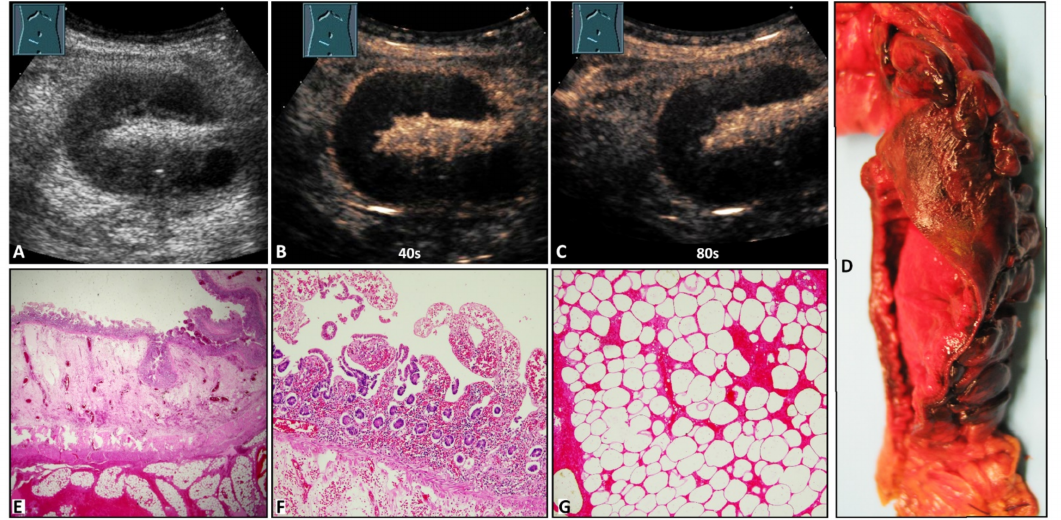
Figure 2. A 42-year-old male patient with acute peritoneal pain in the right lower abdomen and a pal- pable subcutaneously located tumor in the form of a Spieghel’s hernia. ( A ) B-mode ultrasound shows a standing loop of small bowel. ( B , C ) Contrast-enhanced ultrasound shows absent enhancement of the bowel wall after 40 s and 80 s. ( D ) Macroscopic evaluation shows a color change to deep red in the mucosa in an 8 cm long segment. ( E ) Cross section of the small intestine with luminal mucosa, edematous submucosa, muscularis, and hemorrhagic submucosa (from top to bottom). The mucosa shows incomplete ischemic necrosis with vital crypt epithelium (1.25 × magnification). ( F ) Small intestinal mucosa with incomplete ischemic necrosis with vital crypt epithelium (10 × magnification). ( G ) Necrotic mesenteric fat tissue with missing nuclei and hemorrhages (10 ×